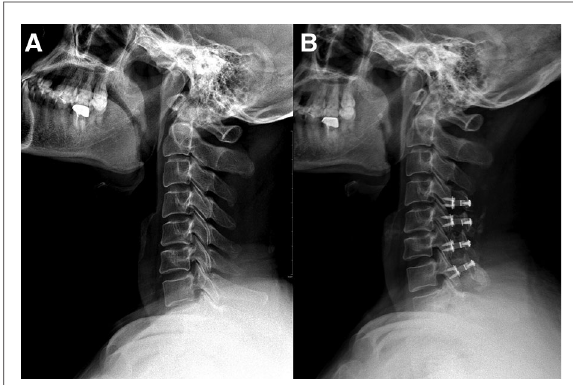
FIGURE 3 A 60-year-old male patient treated with C4 – C7 laminoplasty. ( A ) Preoperative lateral cervical radiograph (CSVA=9.7 mm, T1S= 20.7°). ( B ) Lateral cervical radiograph at fi nal follow-up (19 months after surgery, CSVA=11 mm).